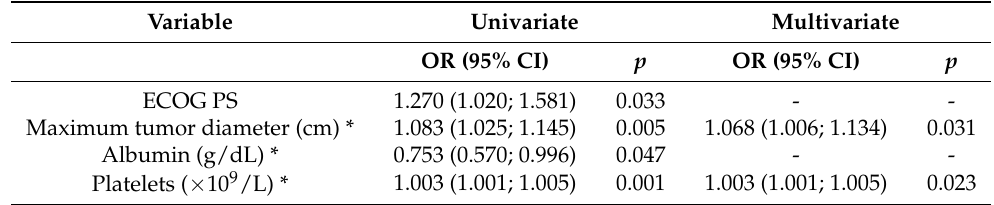
Table 3. Predictors of HCC progression (expressed according to mRECIST criteria) with statistical significance at the univariate and multivariate analysis.